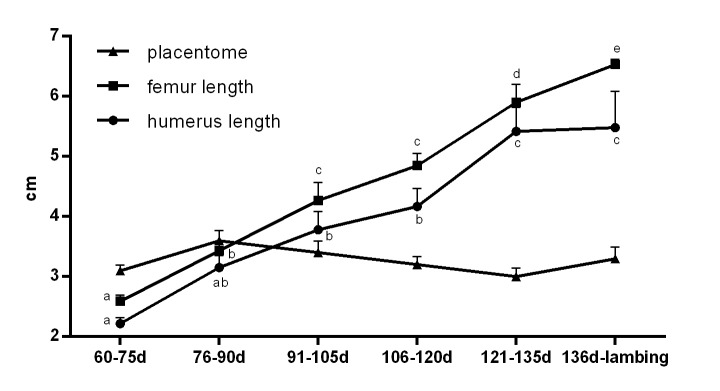
Humerus, femur and placentome lengths (cm) of ovine fetuses throughout pregnancy (n=13). a-eindicate significant differences between time (P<0.05).